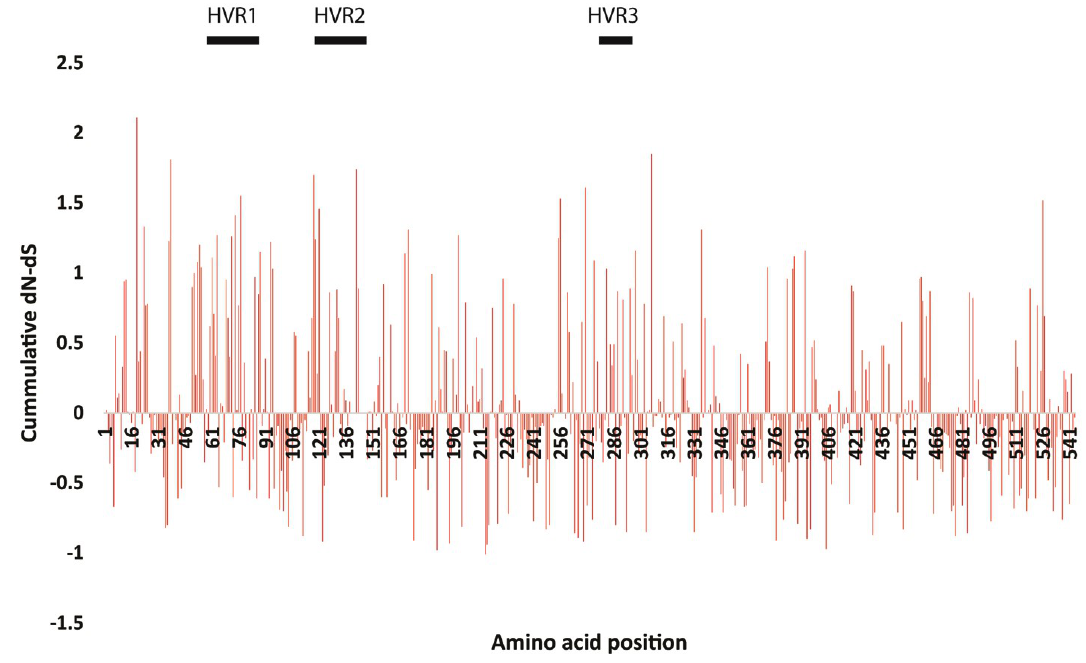
Figure 5. Cumulative dN-dS using SNAP methods along the full length S1 protein of the ACoV strains sequenced in this study.